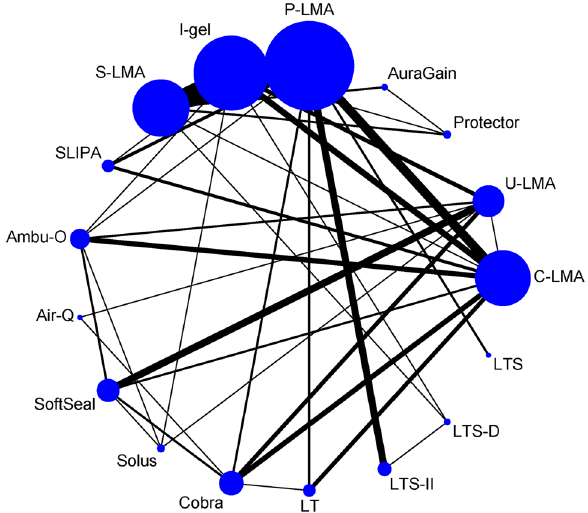
Figure 3. Network of eligible supraglottic airway device comparisons for the risk of first-attempt insertion failure. The line indicates the number of trials and the dots indicate the number of patients. C-LMA, LMA Classic; U-LMA, Unique LMA; Protector, LMA Protector Airway; AuraGain, Ambu AuraGain Disposable Laryngeal Mask; P-LMA, Proseal LMA; I-gel, I-gel supraglottic airway; S-LMA, Supreme LMA; SLIPA, Streamlined Liner of the Pharynx Airway; Ambu-O, Ambu AuraOnce; Air-Q, Air-Q Masked Laryngeal Airway; SoftSeal, The Portex Soft Seal Laryngeal Mask; Solus, Solus Standard Laryngeal Mask Airway; Cobra, Cobra Perilaryngeal Airway; LT, Laryngeal Tube; LTSII, Laryngeal Tube Suction II; LTS-D, Laryngeal Tube Disposable; LTS, Laryngeal Tube Sonda.